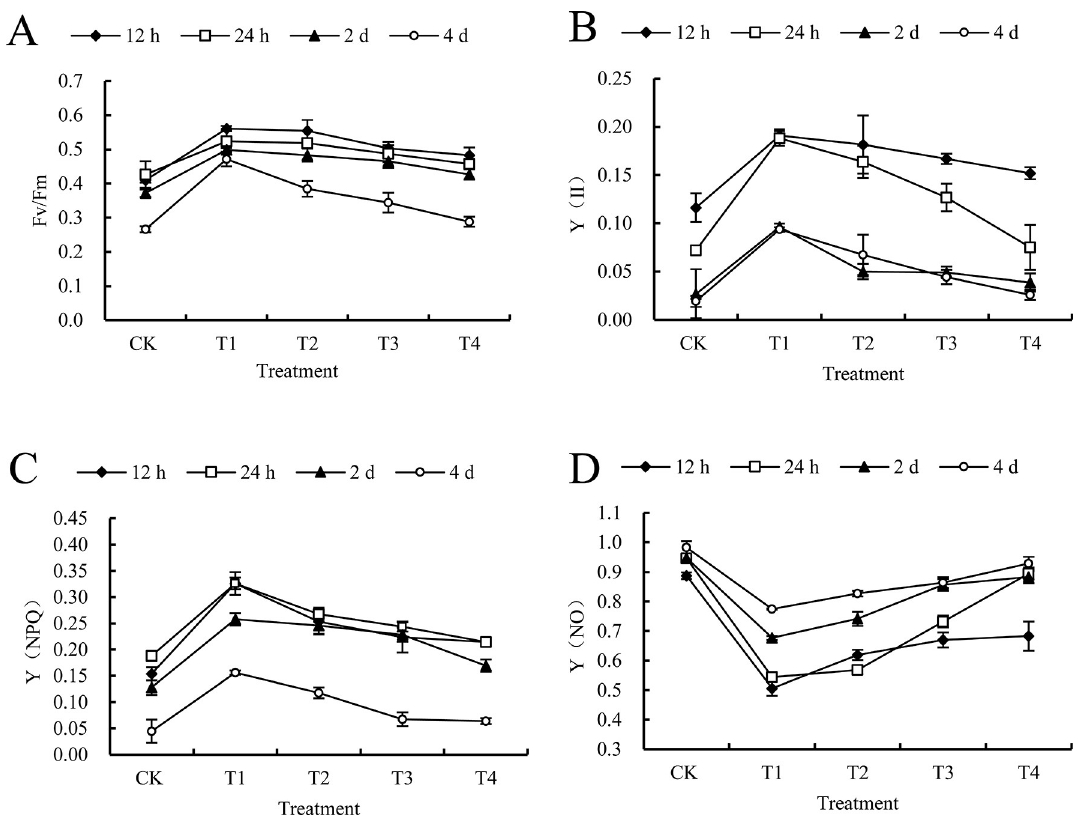
Fig 3. Effect of 6 mm/h rain intensity on chlorophyll fluorescence parameters of C . album treated by mesotrione. CK and T1, T2, T3, T4 on the x-axis represent no rain and different rainfall interval times (0.5 h, 1 h, 2 h, and 4 h) respectively; y-axis represents chlorophyll fluorescence parameters. Diamonds, squares, triangles and circles represent different times after treatment (12 h, 24 h, 2 d and 4 d, respectively). A) the maximum photochemical quantum efficiency (Fv/Fm); B) the actual photochemical quantum yield Y (II); C) the regulated energy dissipation quantum yield Y (NPQ); D) the non-regulated energy dissipation quantum yield Y (NO) of C . album treated by mesotrione. Lowercase letters in the same column indicate significant differences at the 0.05